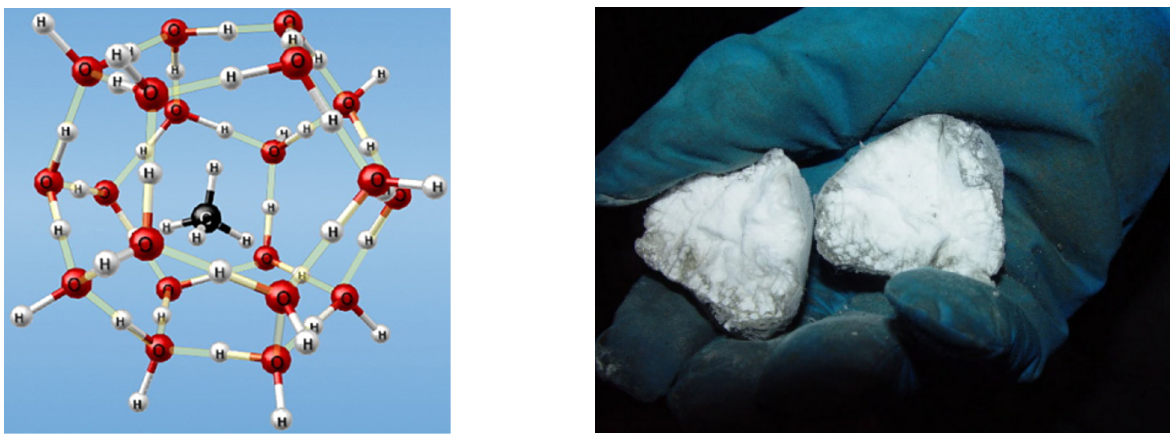
Figure 1. Methane molecule in a cavity of water molecules and the physical appearance of gas hydrates.